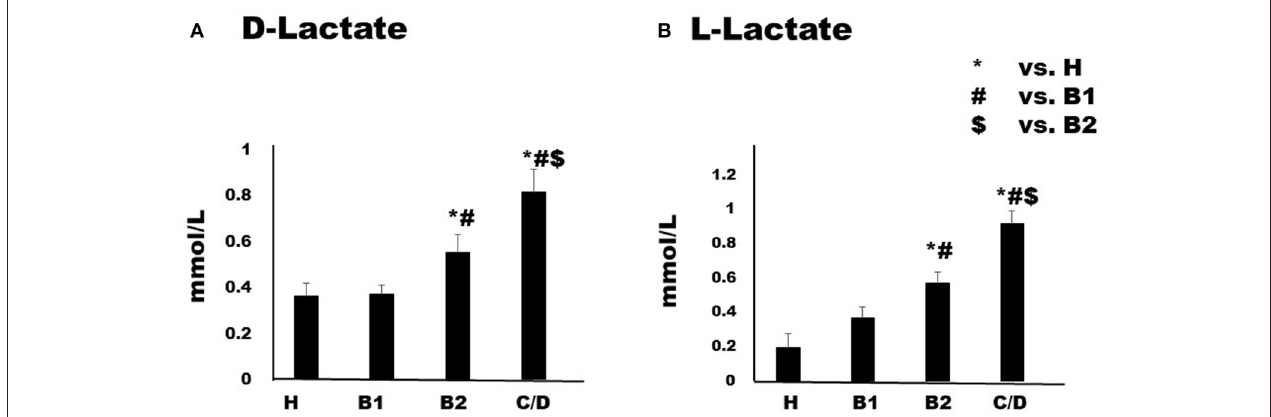
FIGURE 2 | Serum concentrations of D-Lactate (A) and L-Lactate (B) in healthy Chihuahuas (H) and Chihuahuas with myxomatous mitral valve disease divided into three groups (B1, B2, and C/D). One-way ANOVA with post hoc Turkey-Kramer test. Significant difference was considered P <